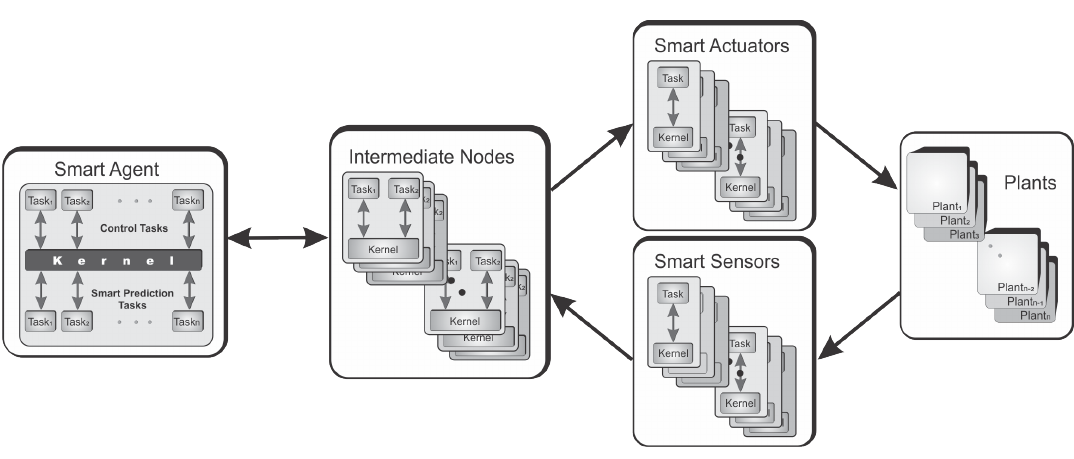
Figure 4. Smart architecture of a WSAN for parallel or multiple control plants. The architecture deployed sensors ( SS i ) and actuators ( SA i ) in each room and intermediate nodes ( R i ), responsible for carrying and returning messages to the controller and